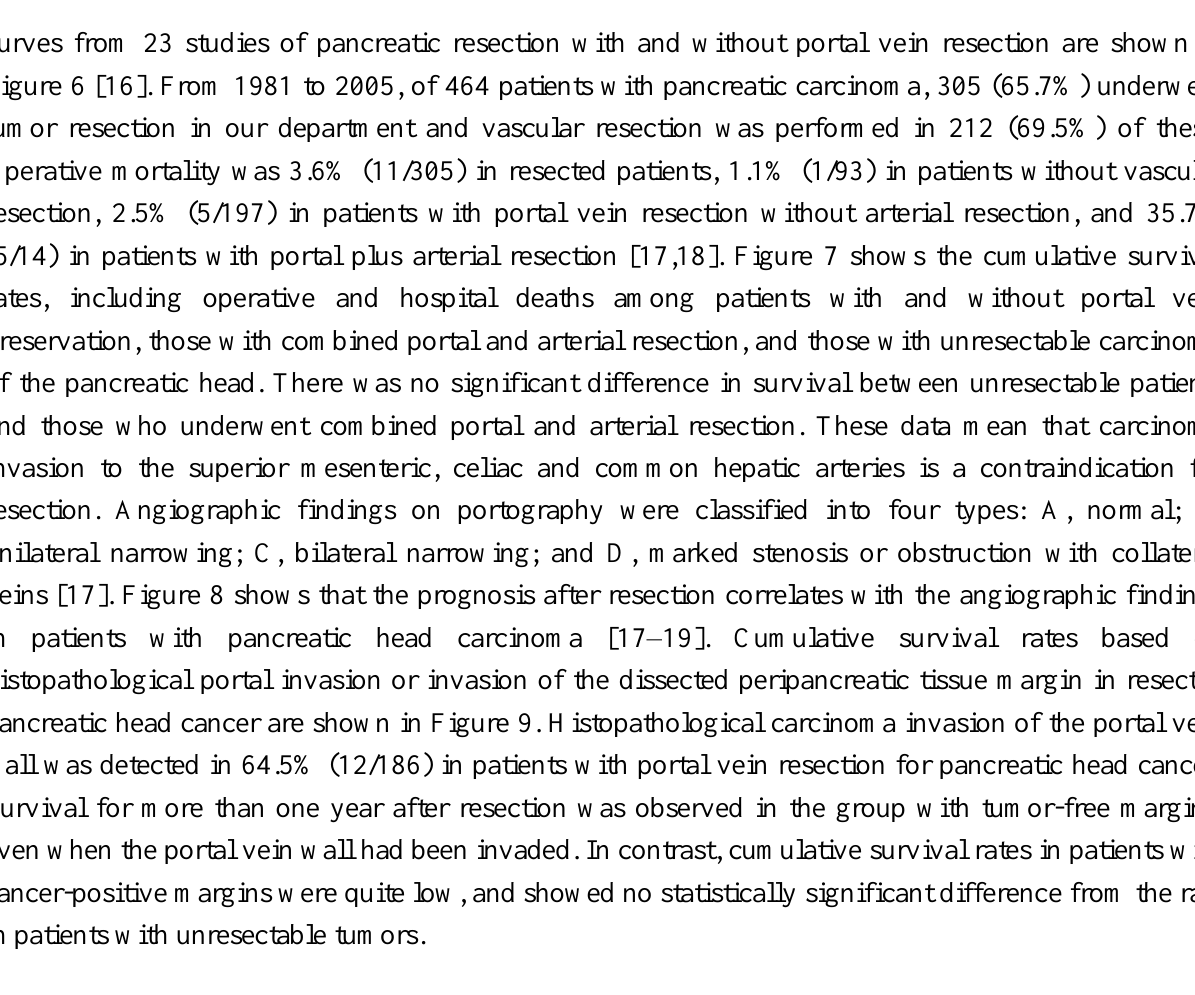
Figure 5. Survival after pancreatic cancer with portal vein resection. The blocks represent the total numbers of known survivors at each time interval (from